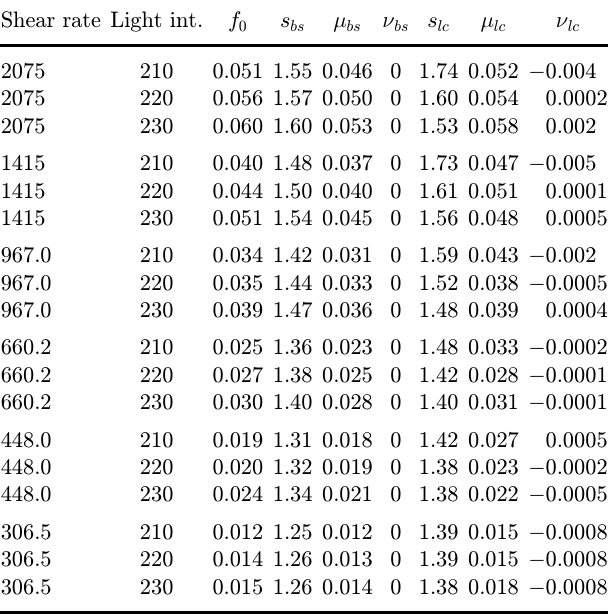
Table 2. Parameters f 0 (normalized light intensity at the iso- intensity lines) and parameters s bs , (cid:1) bs , (cid:7) bs , s lc , (cid:1) lc , (cid:7) lc , charac- terizing the distribution of erythrocytes in shapes, for a blood sample of the rat 4 in shear °ow. The test sample of blood is made up of normal and nondeformable red blood cells in equal amounts (symmetrical ensemble of red blood cells). Di®erent rows in this table correspond to di®erent shear rates of the cell suspension in the ektacytometer and di®erent levels of light intensity at the isointensity lines selected for the measurements. Shear rate Light int.